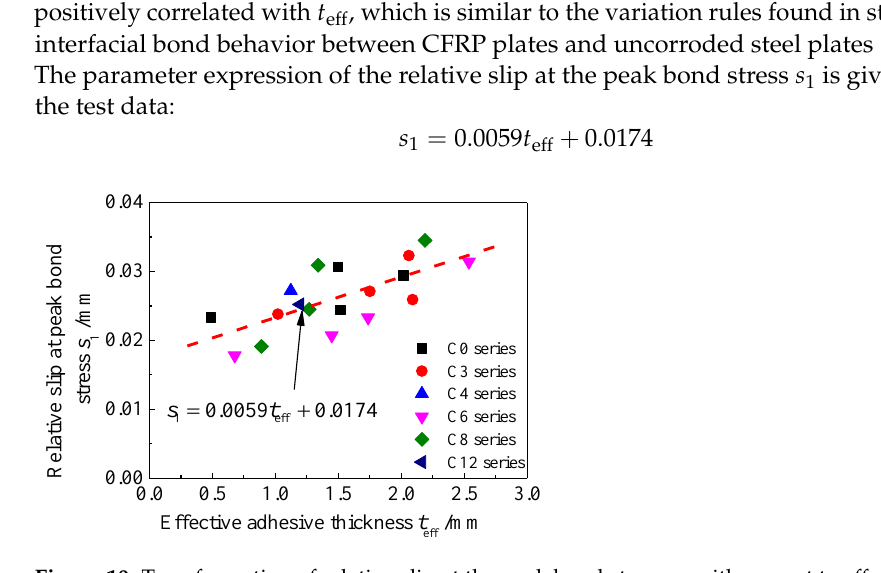
Figure 10. Transformation of relative slip at the peak bond stress t . thickness t adhesive thickness eff eff